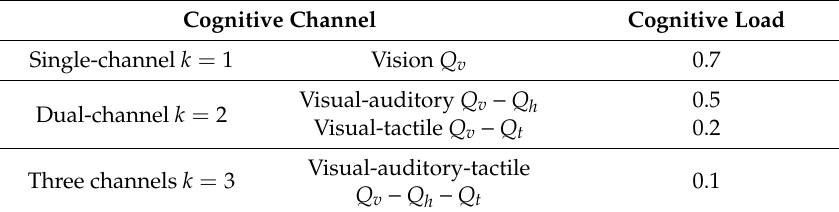
Table 4. Subjective cognitive load questionnaire.